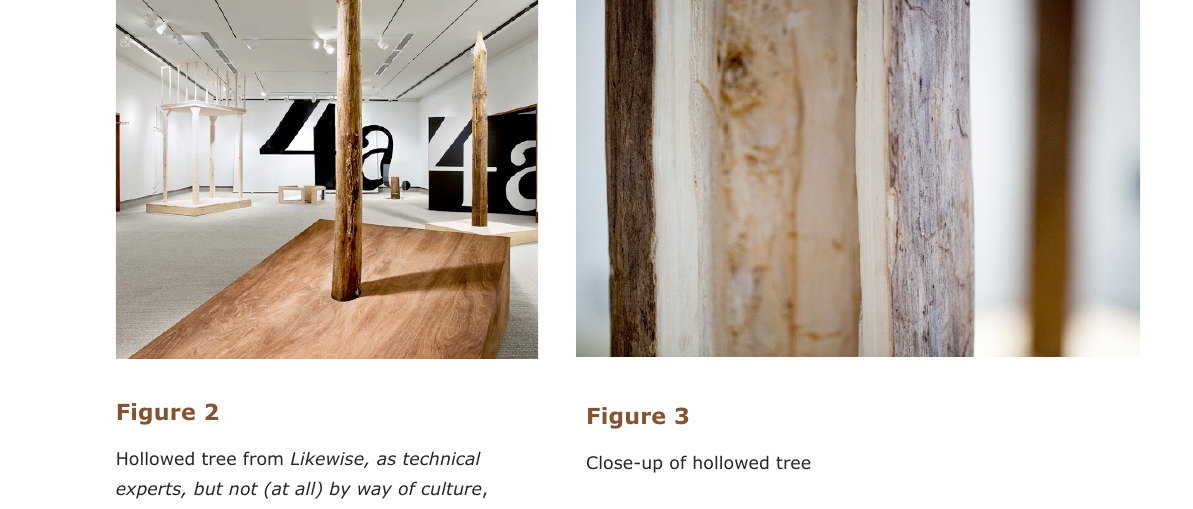
Hollowed tree from Likewise, as technical experts, but not (at all) by way of culture , Cornell Fine Arts Museum,